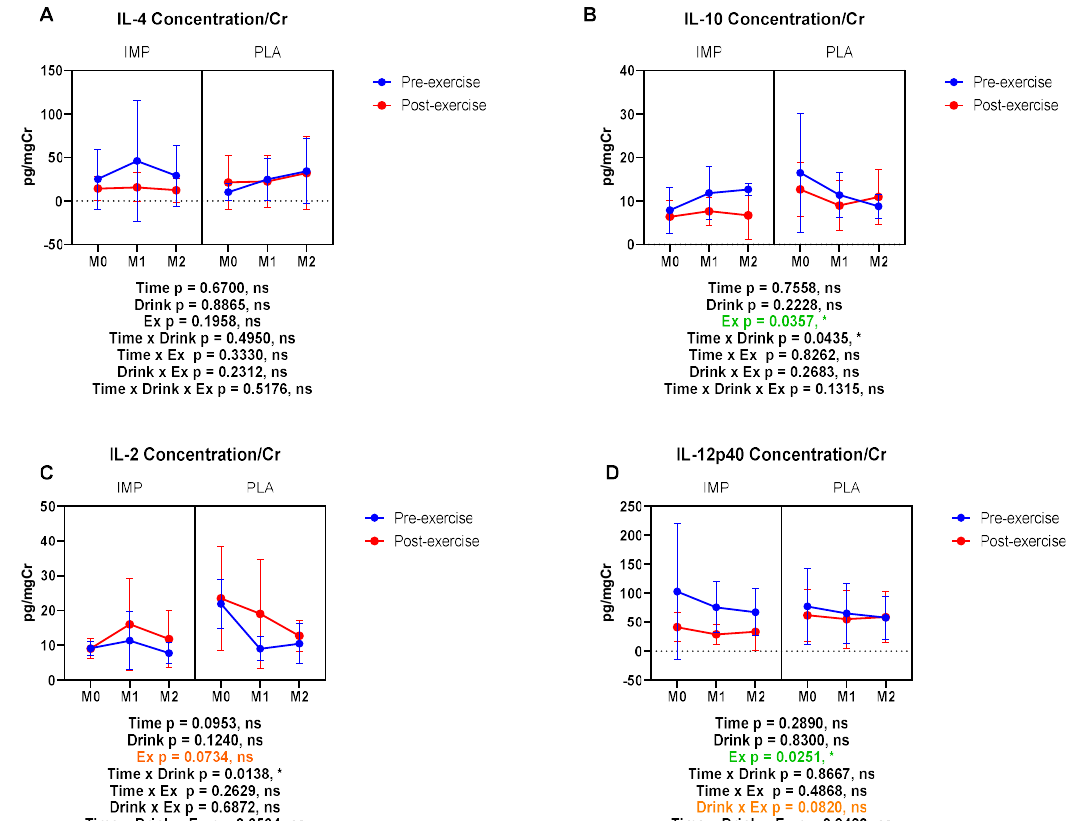
Figure 9. Urine IL-4 ( A ), IL-10 ( B ), IL-2 ( C ), and IL-12p40 ( D ) concentrations corrected with creatinine. The data are presented as means ± SD. * p < 0.05. Green text indicates a significance < 0.05 and orange text indicates an interaction < 0.05.